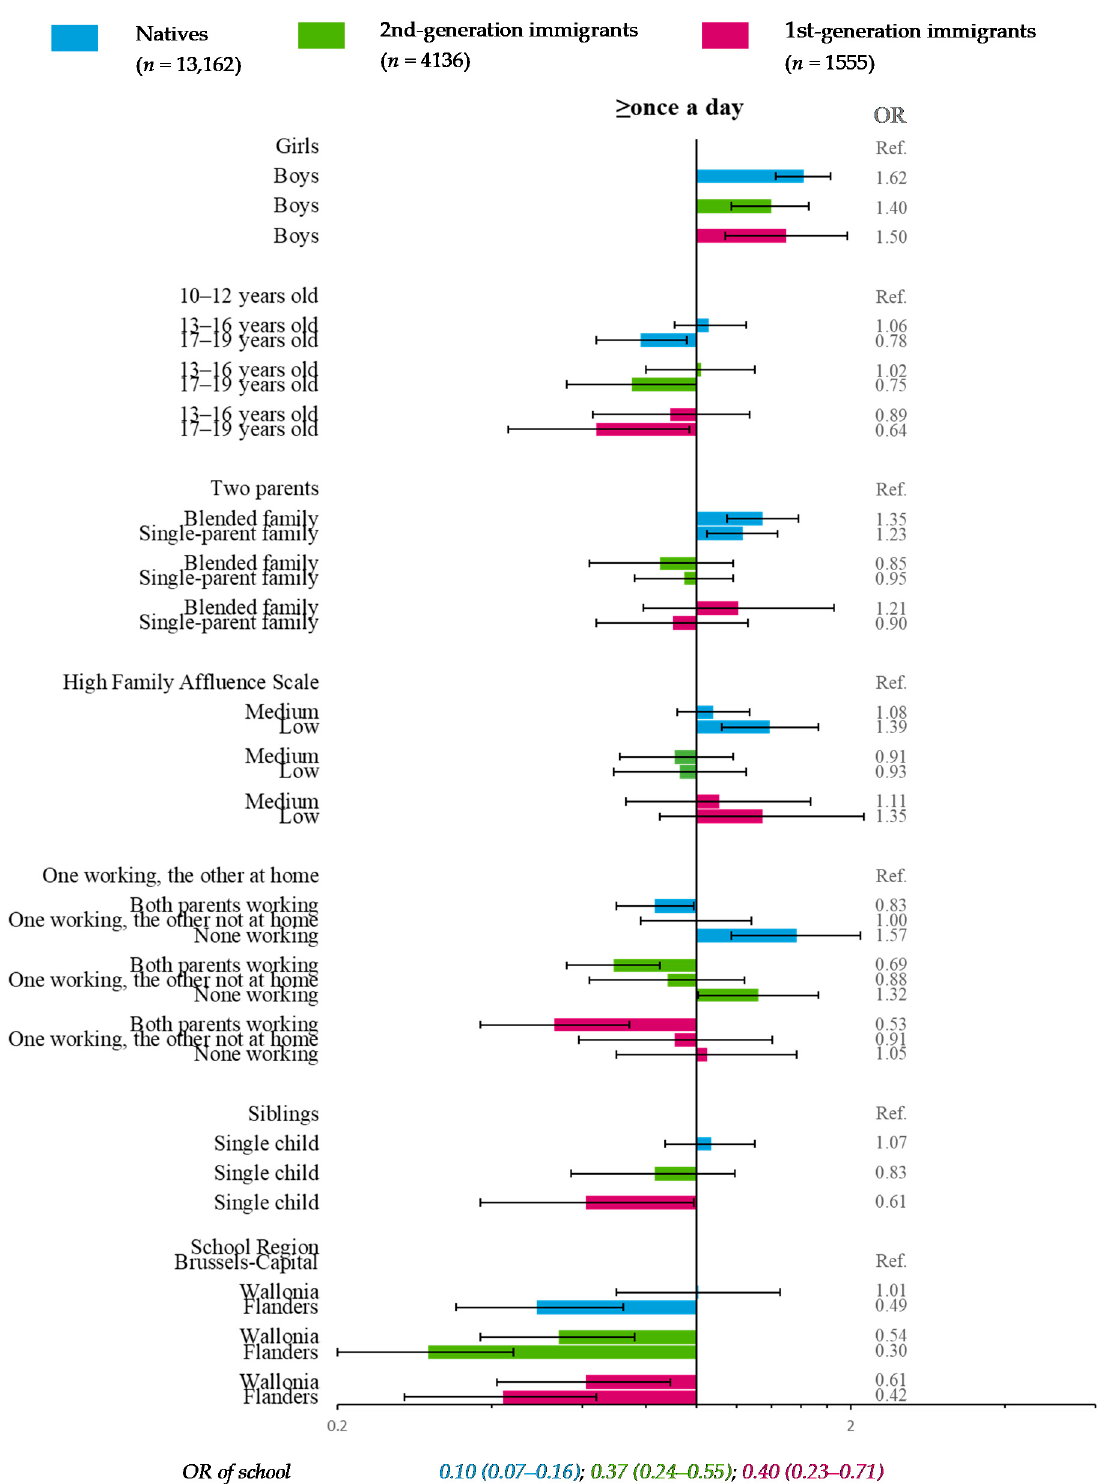
Figure 7. Multiple multilevel logistic regression* for chips and fries consumption (reference category: <once a day) stratified by migration status—HBSC, Belgium, 2014 ( n = 18,853). * OR < 1: More favorable for health; OR > 1: Less favorable for health.